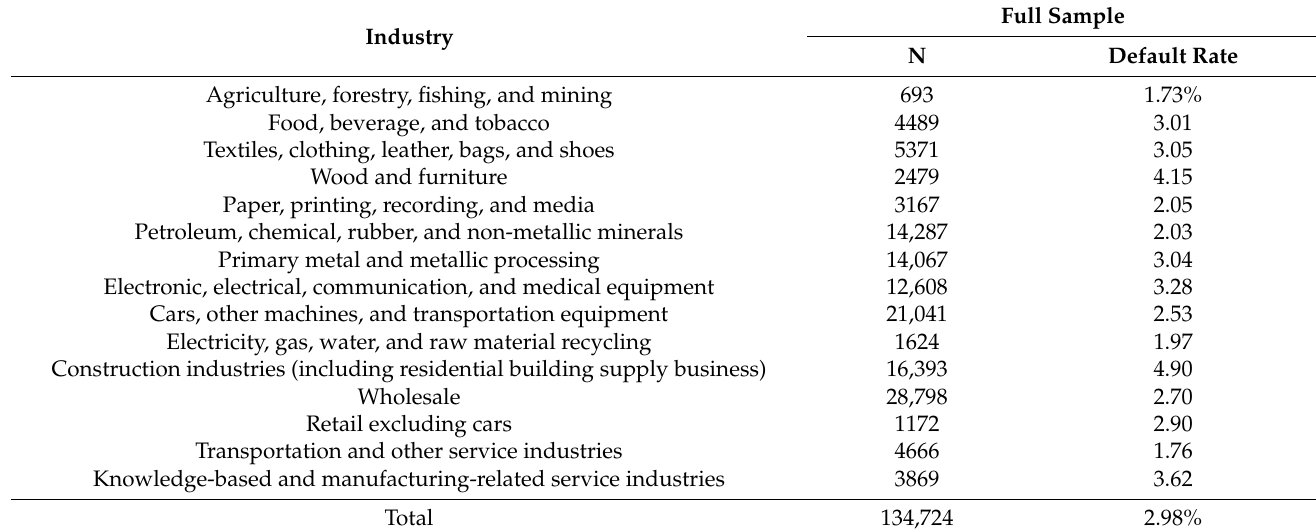
Table 3. Sample industry